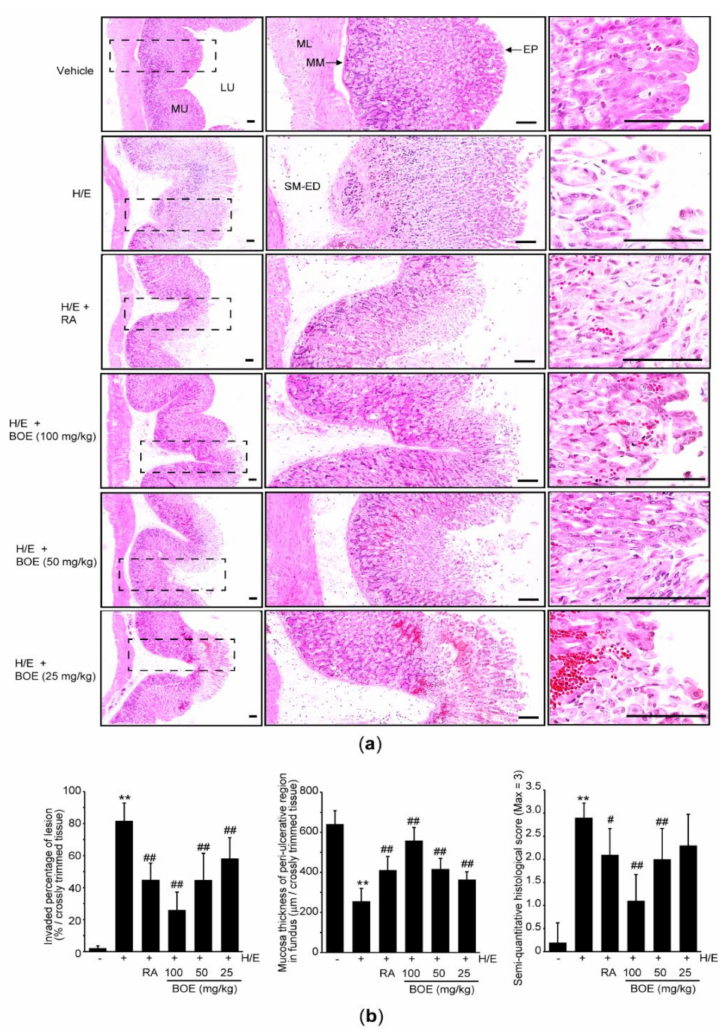
Figure 3. Microscopic effect of BOE on H/E-mediated gastric damage. ( a ) Representative histo- logical image of the fundus/corpus mucosa after staining with hematoxylin and eosin. Dashed squares of left column are enlarged in the middle and right column, and scale bars indicate 80 µ m. ( b ) Histomorphometric analyses. Invaded percentage of lesion, mucosa thickness of peri-ulcerative region, and semi-quantitative histological score were calculated as described in the method section. Numerical results are presented as mean ± SD of ten mice (** p < 0.01 between the vehicle and H/E groups; ## p < 0.01, # p < 0.05 versus H/E-administered group). BOE, B. oleracea var. capitata L. extract; ED, edematous change; EP, surface epithelium; H/E, HCl/ethanol; LU, lumen; ML, muscular layer; MM, muscularis mucosa; MU, mucosa layer; RA, ranitidine hydrochloride; SM,